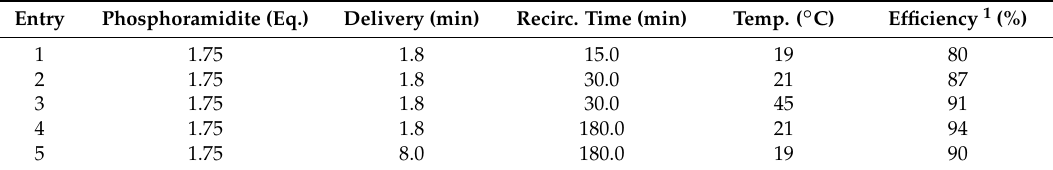
Table 3. Impact of THA-GalNAc phosphoramidite equivalents and reaction temperature on coupling